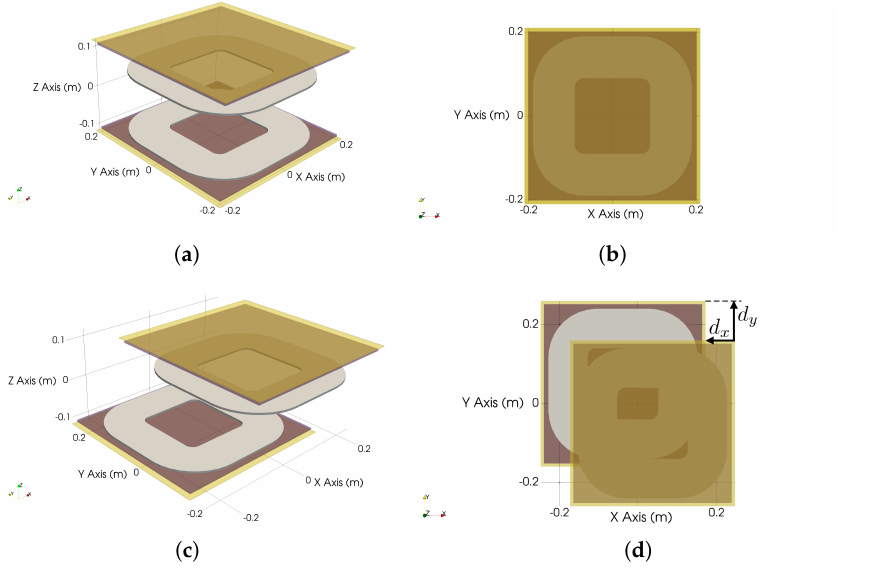
Figure 2. WPT2/Z3 system with perfect alignment ( a , b ) and maximum misalignment ( c , d